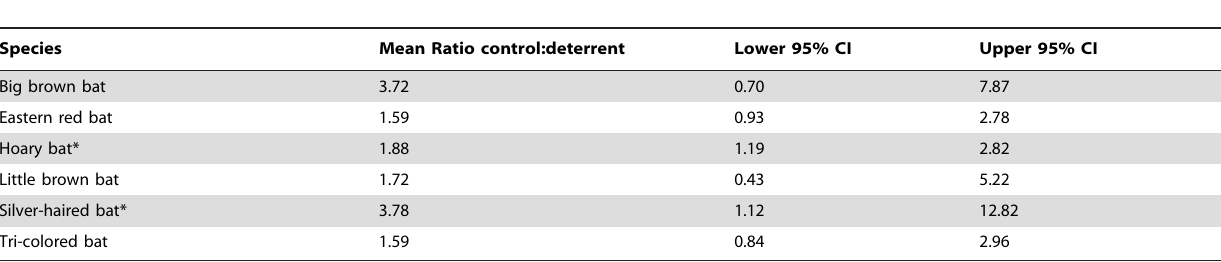
Table 7. Ratio between bat fatalities per control turbine relative to treatment turbines (mean and 95% confidence intervals [CI]) for each species of bat from the Locust Ridge Wind Project in Columbia and Schuylkill Counties, Pennsylvania, 31 July–9 October